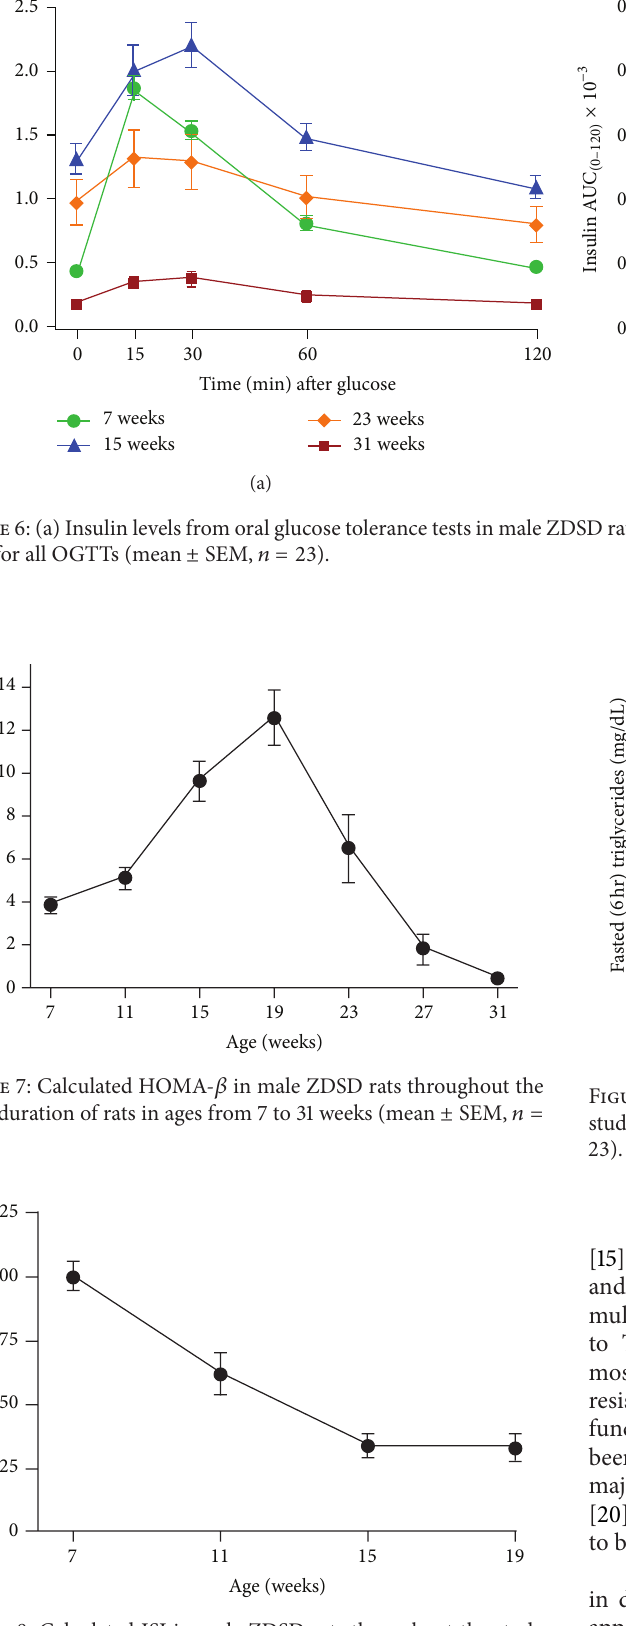
Figure 8: Calculated ISI in male ZDSD rats throughout the study duration of rats in ages from 7 to 19 weeks (mean ± SEM, 𝑛 = 23 ).